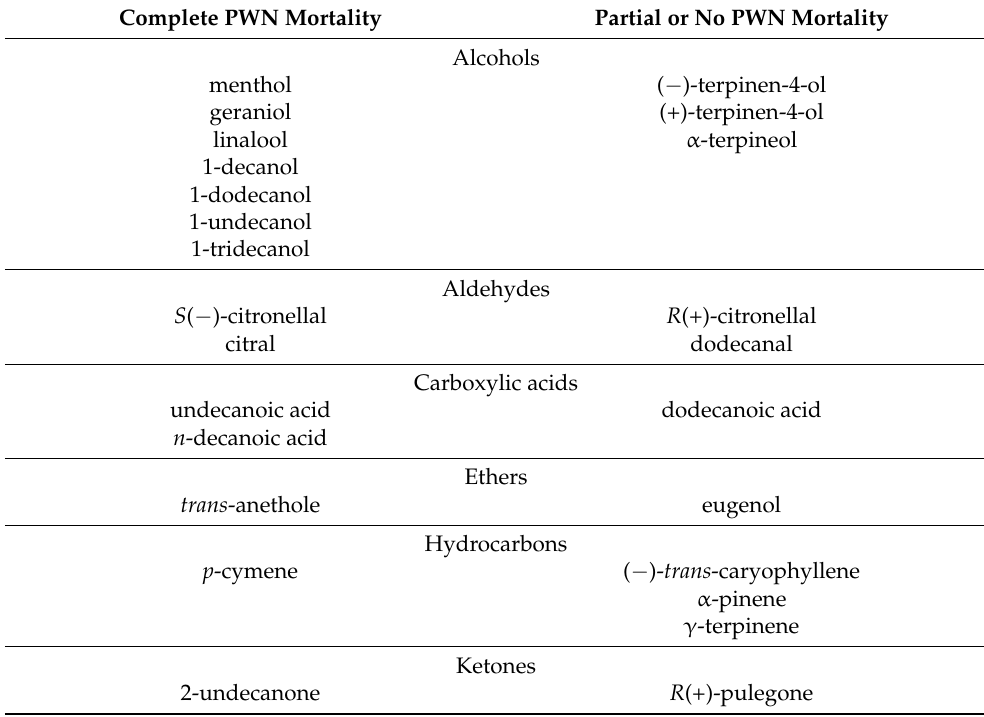
Table 1. PWN mortality after 24 h of direct contact with 25 cyclic and linear compounds (1 mg/mL). Complete PWN Mortality Partial or No PWN Mortality Alcohols